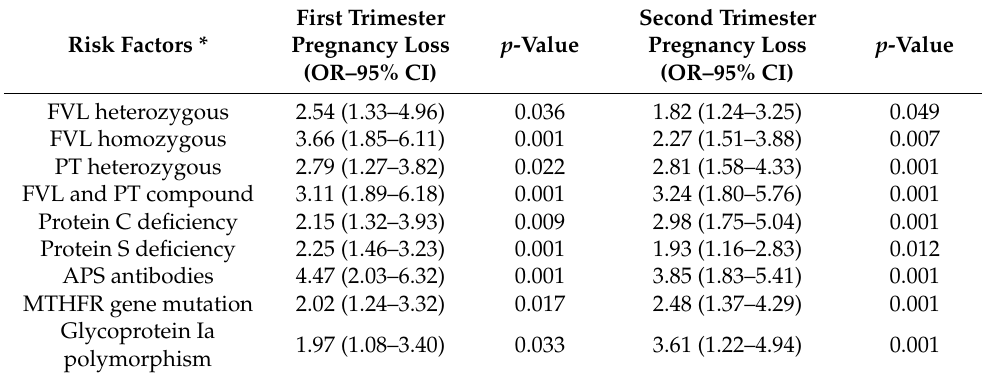
Table 4. Risk factor analysis for first and second trimester pregnancy loss.